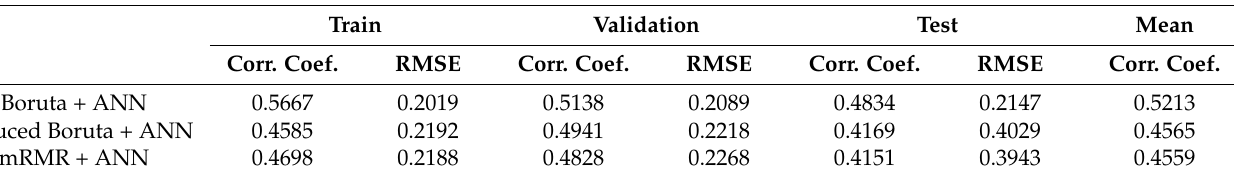
Table 3. ANN results for the best-performing models (among 100) for students’ satisfaction with the online teaching method, using the variables selected by Boruta and mRMR, and the set of re- duced Boruta. The table shows the correlation coefficient and the root mean square error (RMSE) for the train, test, and validation sets.